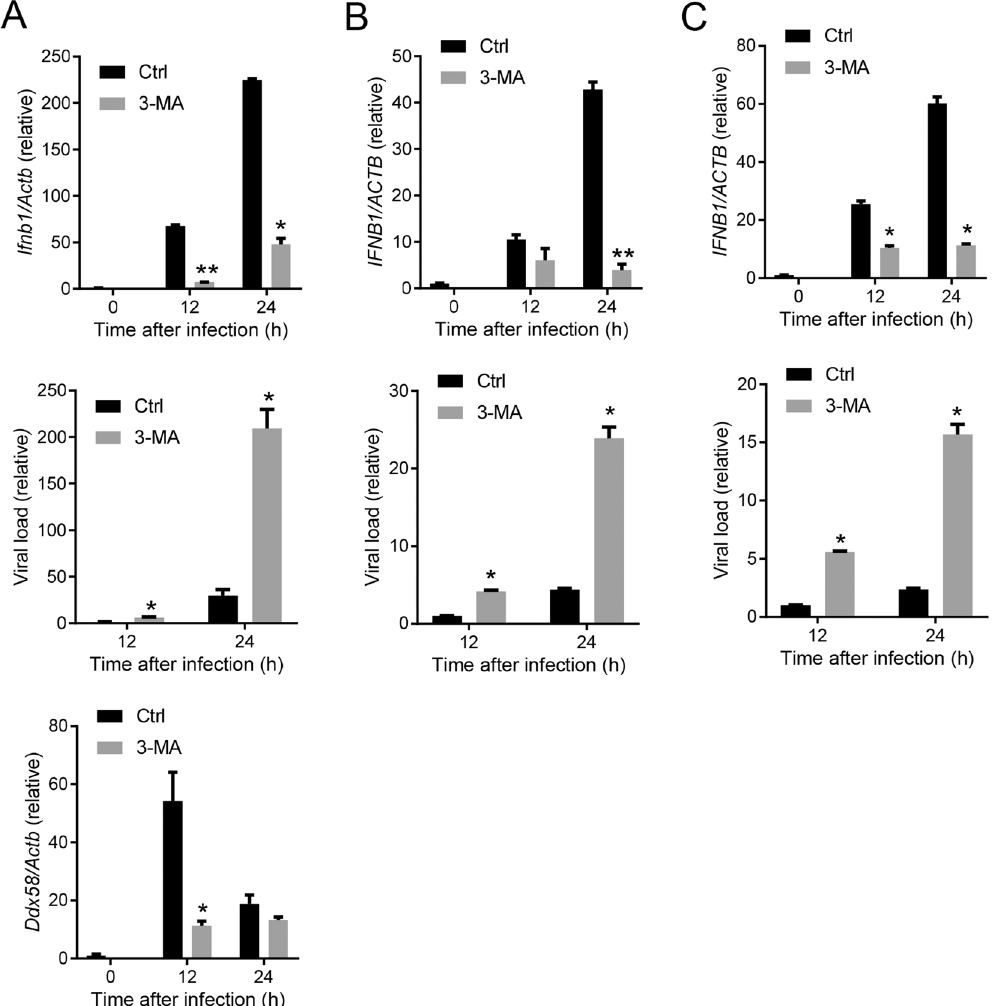
Figure 3. Inhibition of PI3K impairs WNV-induced immune responses in mouse embryonic fibroblasts and human cells. ( A ) MEFs, ( B ) THP-1 and ( C ) H1975 cells were infected with WNV without (Ctrl) or with 2 mM 3-MA for the indicated time. The cellular viral loads and transcript levels of selected immune genes were quantified by q-PCR. The results of immune gene expression are expressed as fold induction in WNV infected cells over mock (0 h). The viral loads are expressed as fold change over 12 h Ctrl cells. Bar: the mean of the result + s.e.m. * p < 0.05, ** p < 0.001 (unpaired Student’s T-test). The data shown are representative of 2 independent reproducible